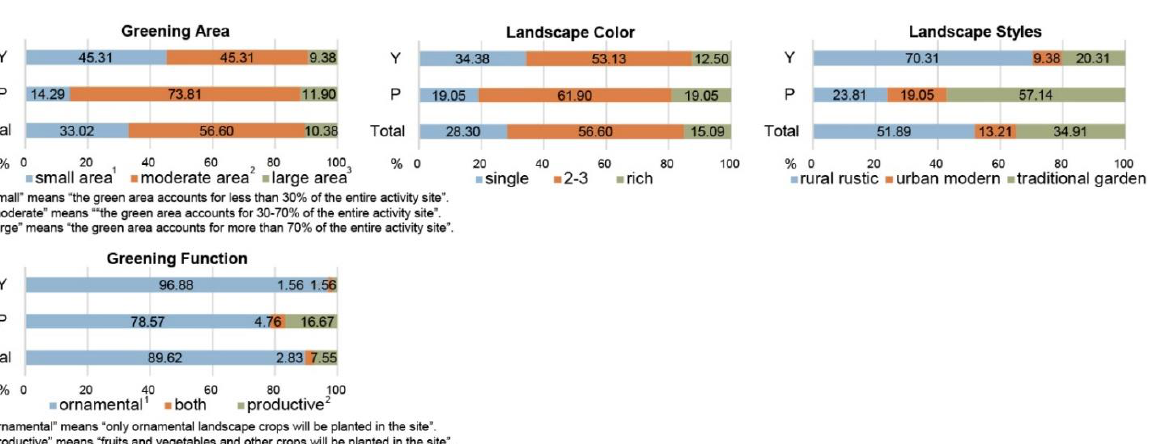
Figure 5. Survey statistics of respondents ’ spatial accessibility preferences.